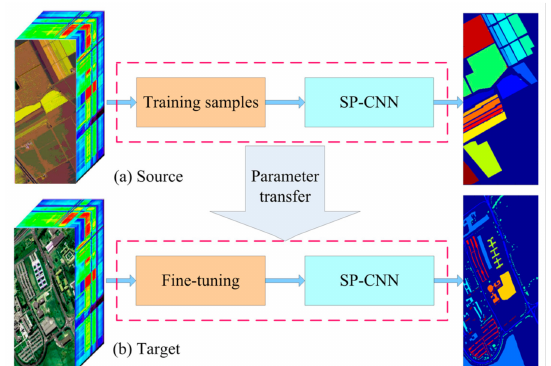
Figure 4. Transfer learning on the SP-CNN. ( a ) Pre-training SP-CNN on source hyperspectral image (HSI). ( b ) SP-CNN classifies for target